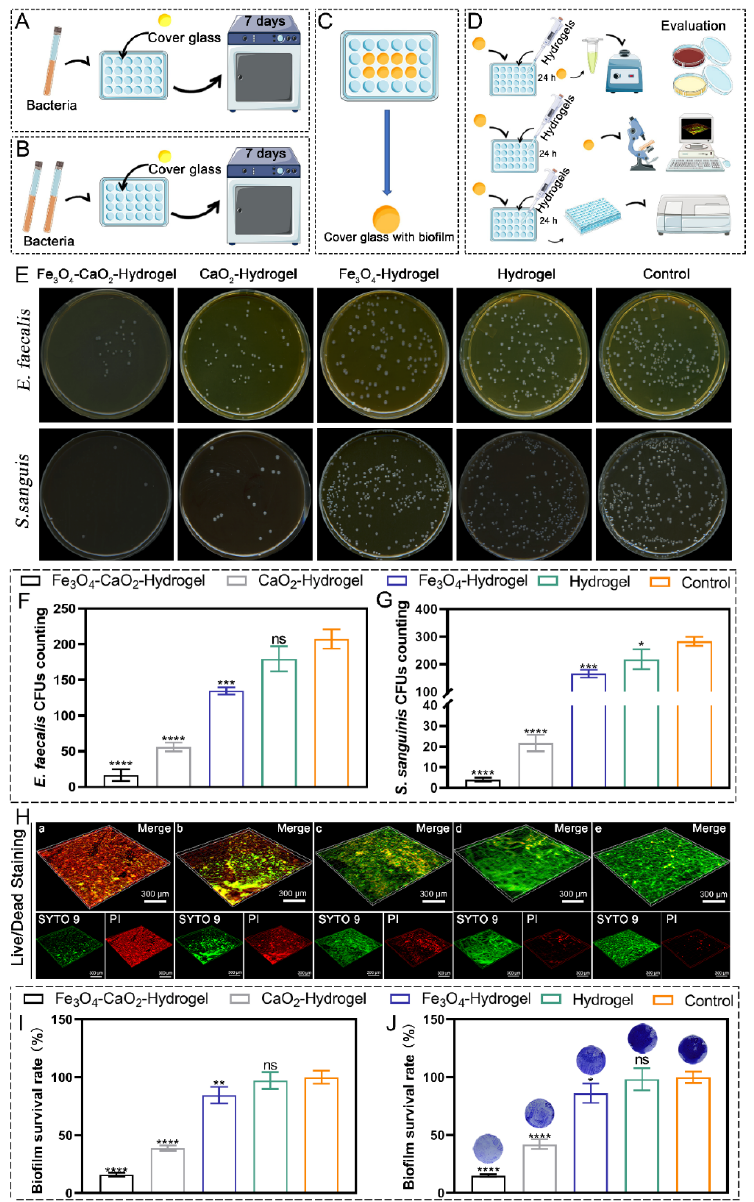
Figure 3. In vitro antibacterial tests. ( A ) Formation of single-strain biofilms. ( B ) Formation of multi- species biofilms. ( C ) Biofilm formation on the surface of the cover glass. ( D ) Antibiofilm Evaluation of Hydrogels. ( E ) bacterial colony plate counting. ( F , G ) The corresponding quantitative analysis ac- cording to colony plate counting. ( H ) Live/Dead staining of bacterial biofilm, live bacteria were stained by SYTO 9, resulting in green fluorescence. Dead bacteria with damaged cell membranes were stained by PI, resulting in red fluorescence. a: Fe 3 O 4 -CaO 2 -Hydrogel, b: CaO 2 -Hydrogel. c: Fe 3 O 4 -Hydrogel. d: Hydrogel. e: Control. ( I ) MTT assay measuring the bacterial biofilm activity in different groups. ( J ) Crystal violet staining assay measuring the bacterial biofilm activity in different groups, Inset: Staining status of the cover glass after treatment in different groups. * p < 0.05, ** p < 0.01, *** p < 0.001, **** p < 0.0001. ns, not significant. 2.6. Effect of the Modified Nanozyme-Loaded Hydrogel on Bacterial Structure SEM results (Figure 4A) showed that each group exhibited different extents of dam- age to the cell membrane structure. Bacteria treated with Fe 3 O 4 -CaO 2 -Hydrogel and CaO 2 -